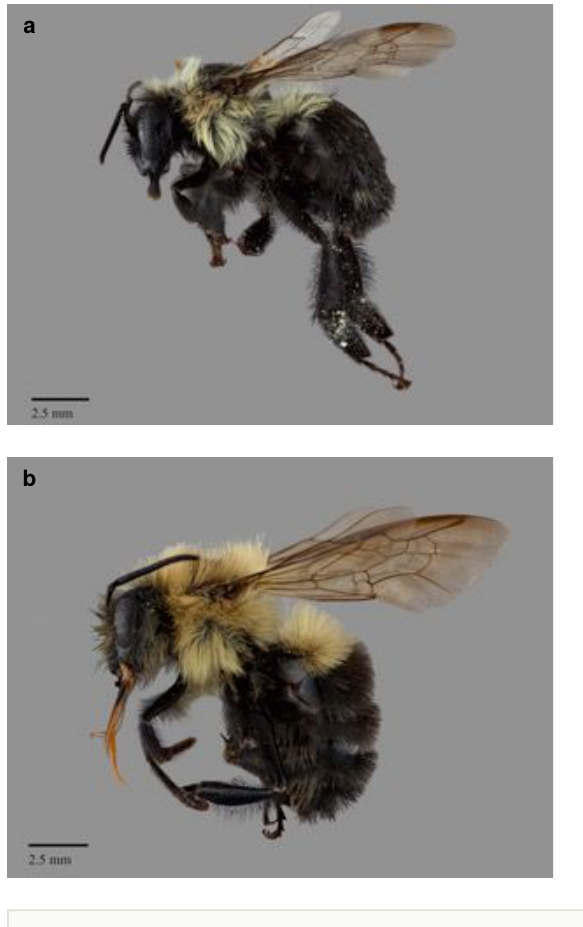
Figure 2. Specimens of Bombus impatiens Cresson collected in south-eastern Alberta,